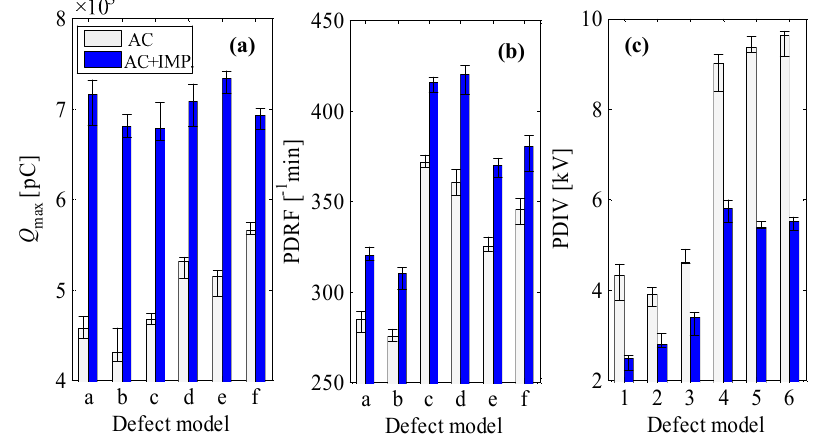
Figure 13. PD parameters of six PD models under two distinct voltage waveforms. ( a ) The maximum PD quantity, ( b ) the PD repetitive voltage, and ( c ) the PD inception voltage.